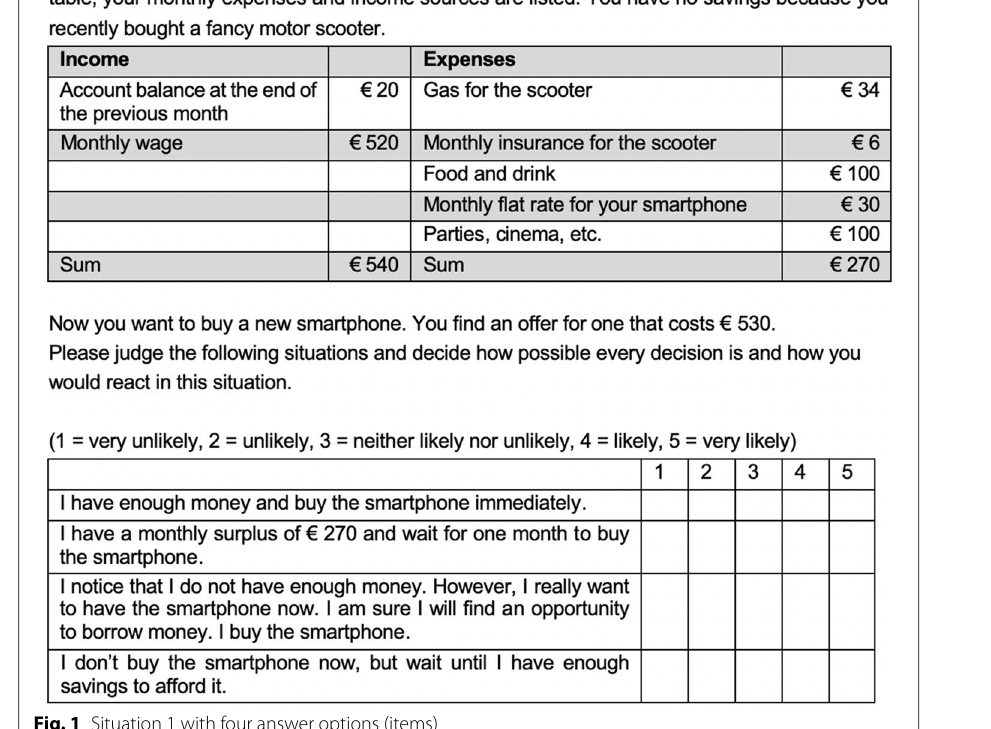
Fig. 1 Situation 1 with four answer options (items)